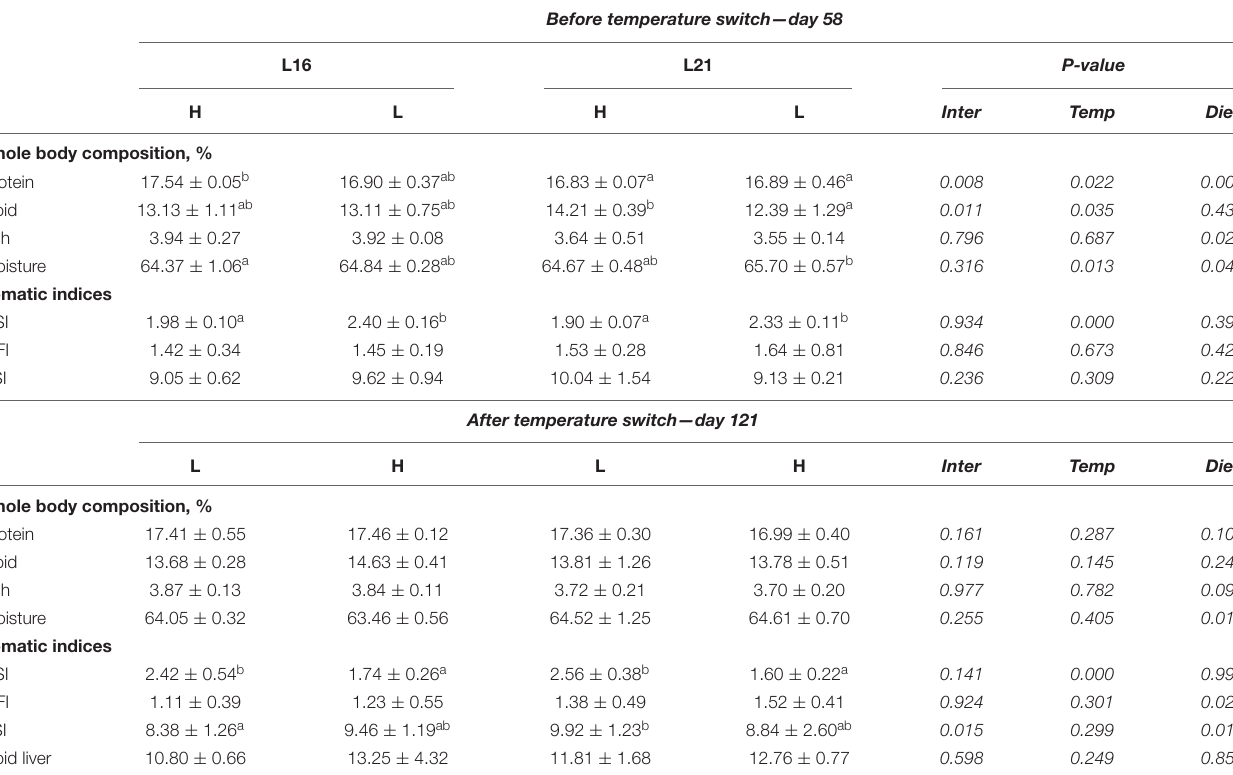
TABLE 3 | Body composition and somatic indices of gilthead sea bream fed experimental diets and exposed to water temperature switch. Before temperature switch—day